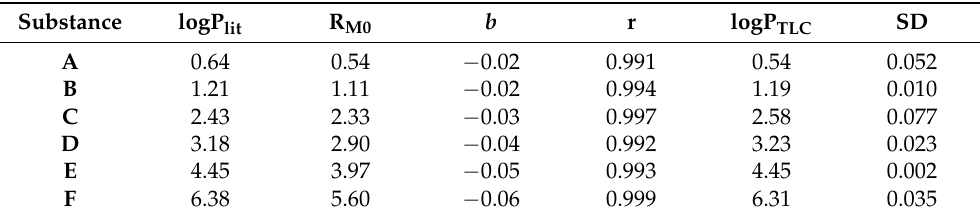
Table 2. The literature (logP lit ) and experimental (R M0 , b , and logP TLC , r and SD) values for the reference compounds A – F